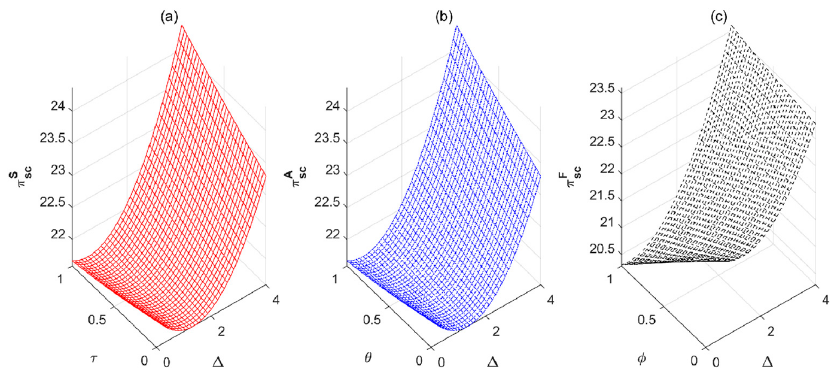
Figure 4. ( a ) Effect of τ and ∆ on supply chain profit under retailer’s cost-sharing practice. ( b ) Effect of θ and ∆ on supply chain profit under retailer’s altruistic preference practice. ( c ) Effect of φ and ∆ on supply chain profit under retailer’s fairness concern practice.